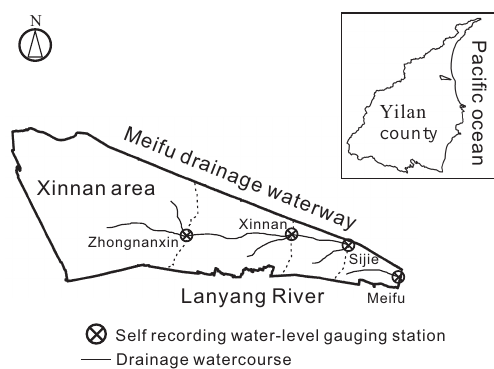
Figure 1. Xinnan area in Yilan County,